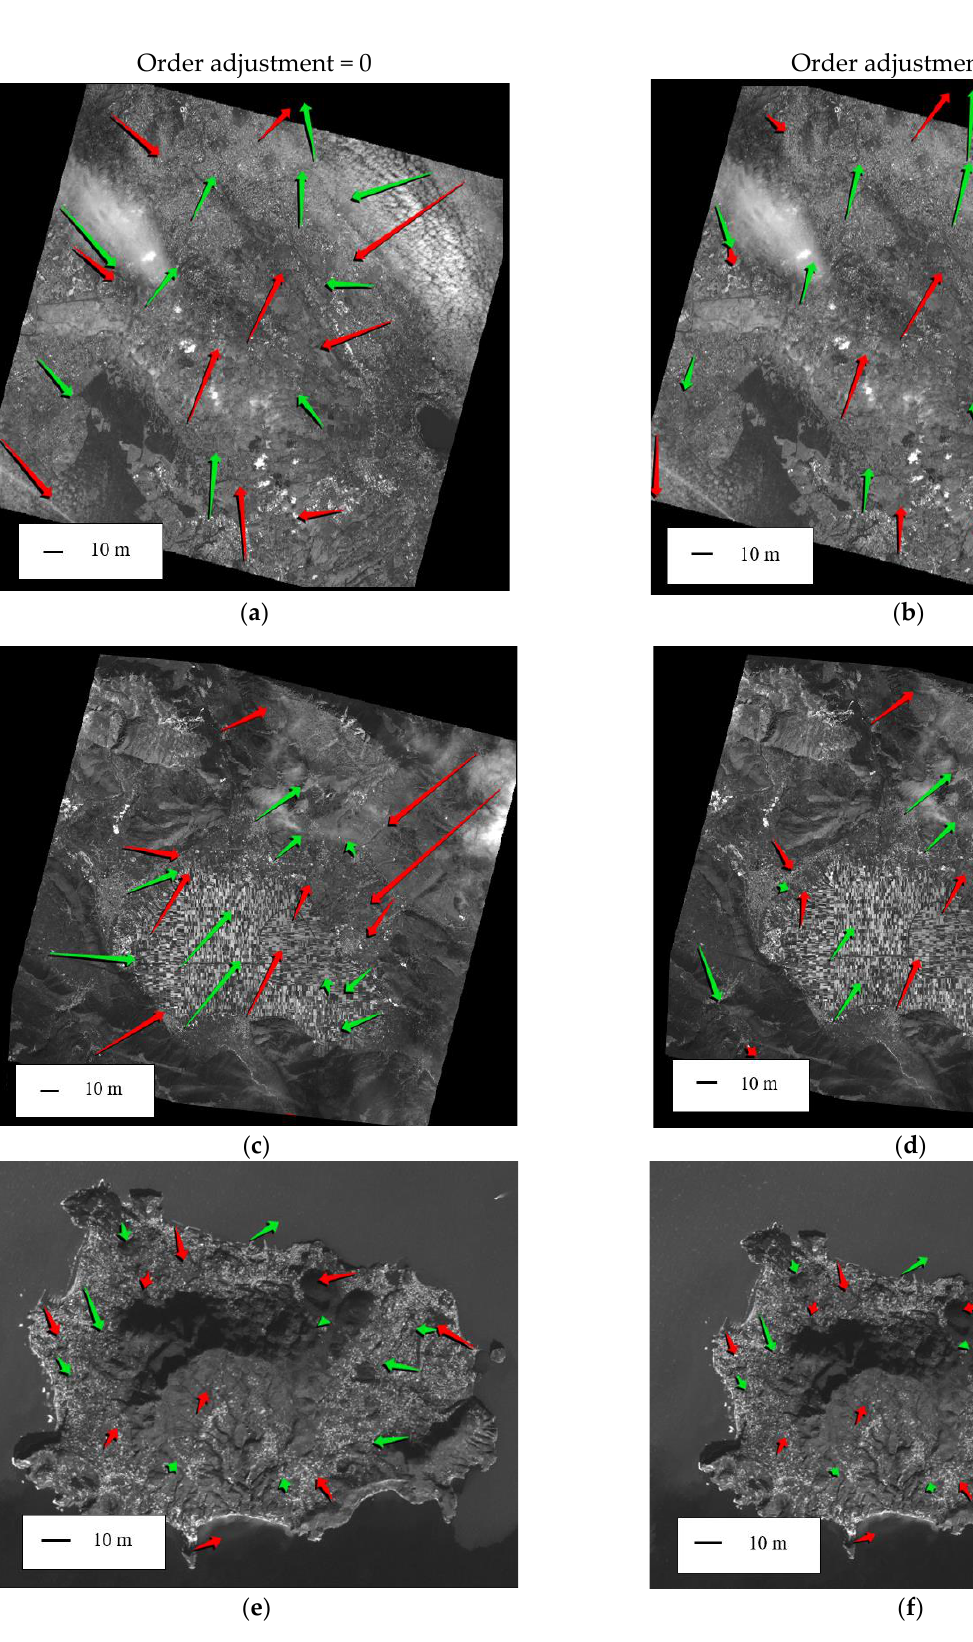
Figure 10. Planimetric errors for RPC order 0 and order 2 solution — test field of Rome ( a , b ), Fucino ( c , d ) and Ischia ( e , f ).